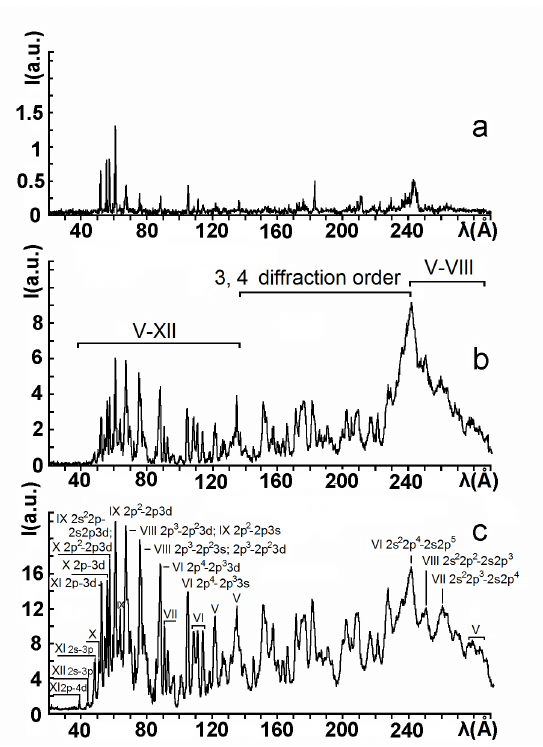
Fig. 3. Emission spectra of the Al discharge plasma for U = 10 kV, I ≈ 17 kA, J = 70 mJ (a); 16 kV, 28 kA, 70 mJ (b); and 16 kV, 28 kA, 200 mJ